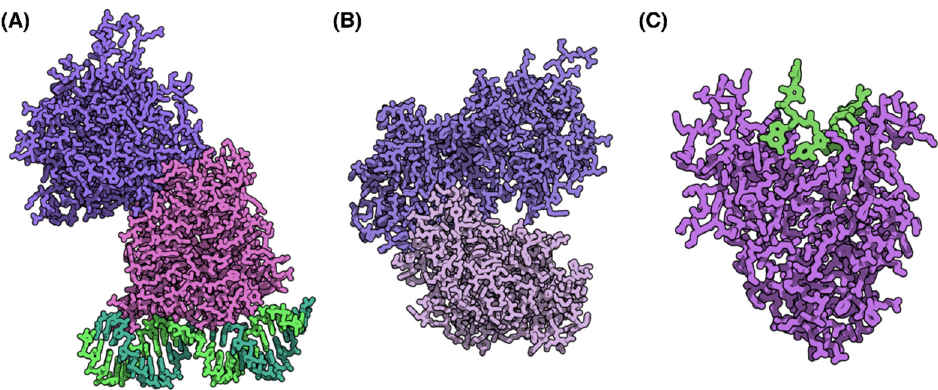
Figure 4. Host Proteins with RNA editing functions. ( A ) Human Adenosine Deaminase Acting on dsRNA (in purple) bound to dsRNA (in green, PDB 5ED1, [83]). ( B ) Apolipoprotein B mRNA-editing enzyme, catalytic polypeptide-like 3G (APOBEC3G, PDB 6P3X, [82]). ( C ) Zinc-finger antiviral protein (ZAP) bound to RNA (in green, PDB 6L1W, [93]). Protein structures modified with QuteMol [46].